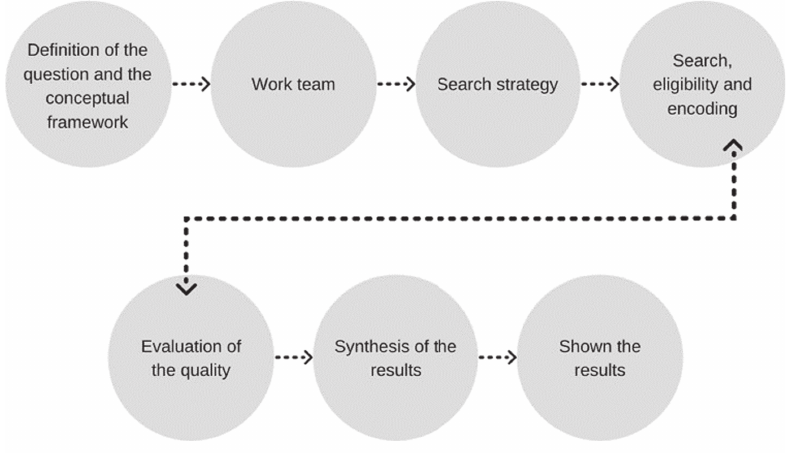
Figure 1. Method for the systematic literature